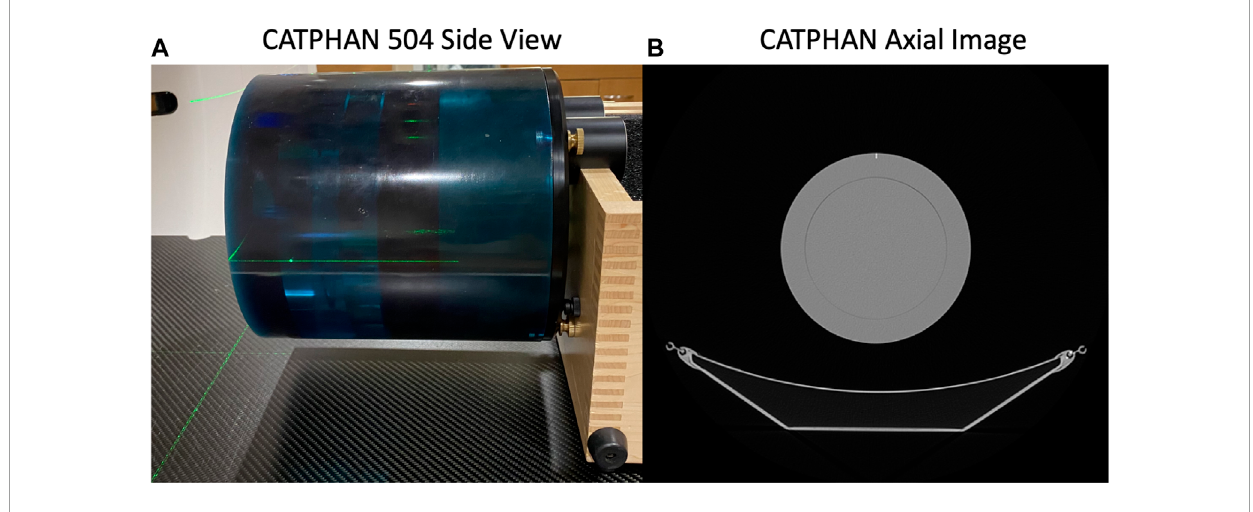
FIGURE 1 The CATPHAN 504 imaged in this study is shown (A) setup on the CT table and (B) with an axial CT image of the uniformity region.